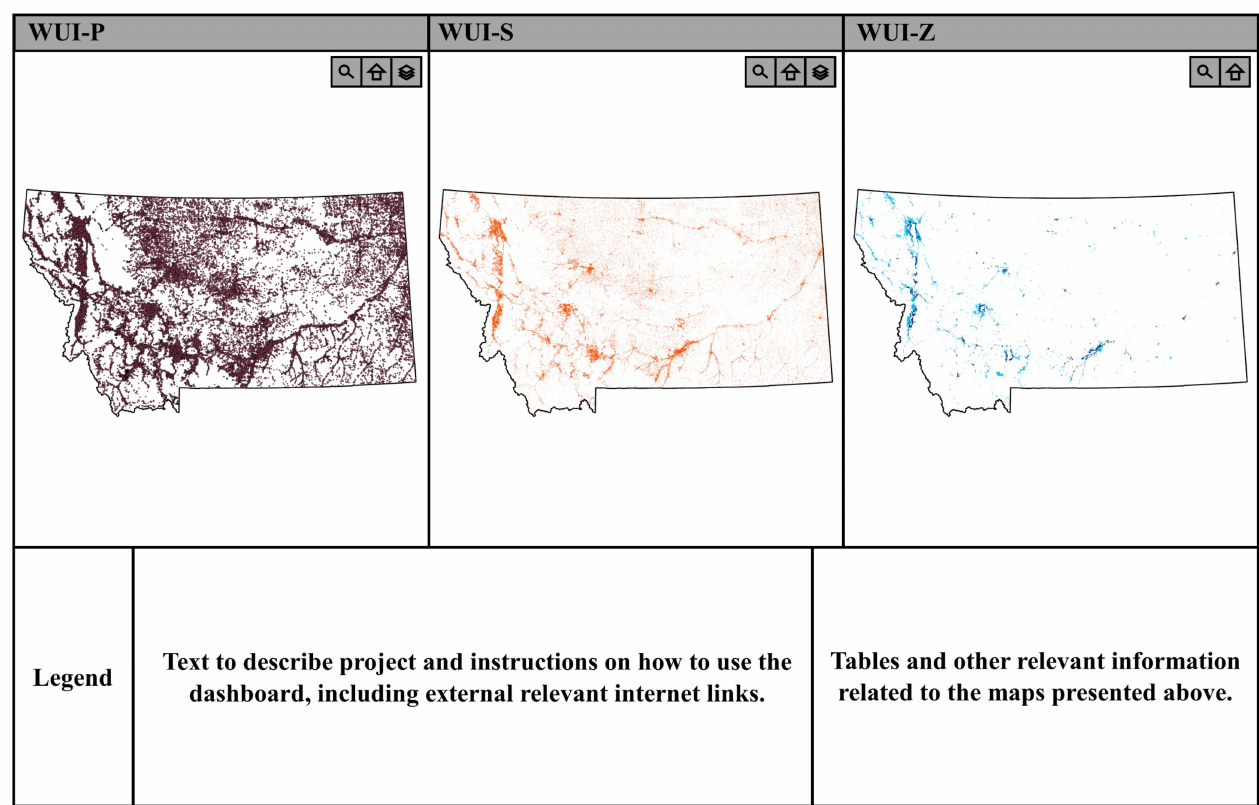
Figure 5. The design of the graphical user interface (GUI) for the web GIS